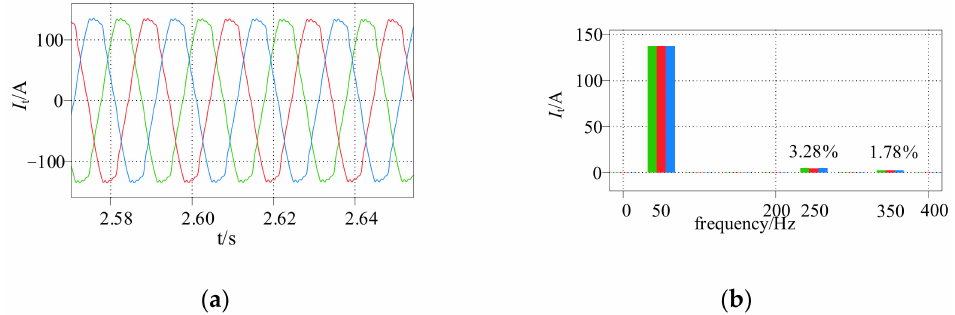
Figure 10. ( a ) Current of a GFL converter ( P set = 25,000 W, SCR = 4.84); ( b ) current THD of a GFL converter ( P set = 25,000 W, SCR = 4.84). (Green for phase A, red for phase B, blue for phase